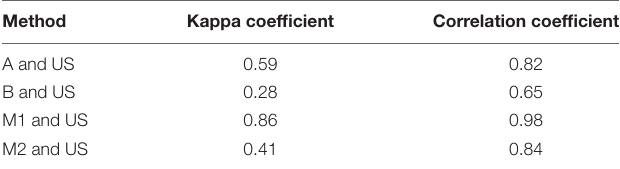
TABLE 3 | Kappa coefficients, Pearson correlation coefficients between the scores of the two rehabilitation therapists, and the two methods, and the uniform scores.